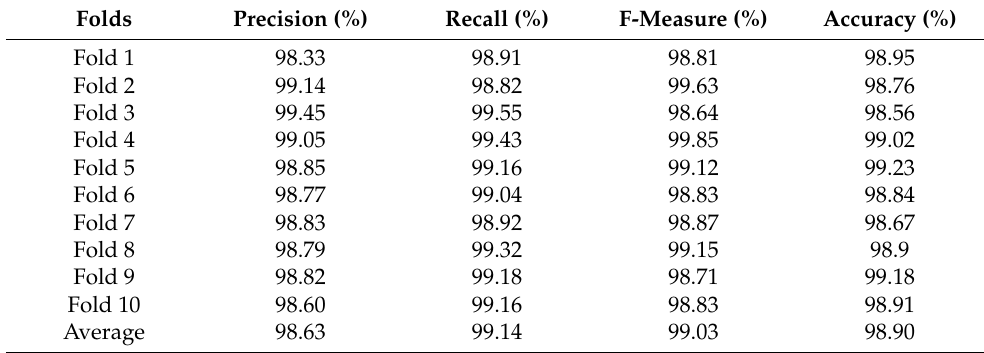
Table 4. Evaluation and Characteristics of Architecture on each Fold.